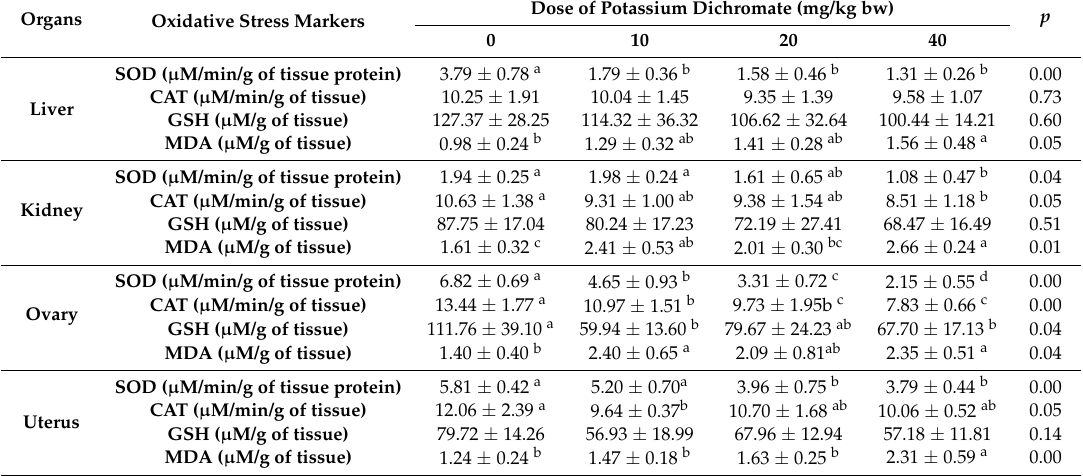
Table 6. Effects of potassium dichromate on oxidative stress markers in rabbit